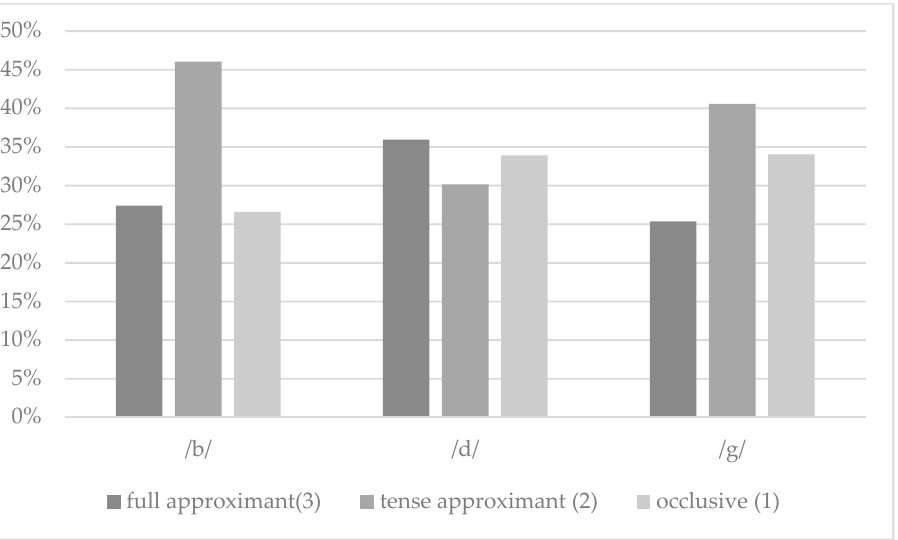
Figure 4. Rates of production types for all segments.